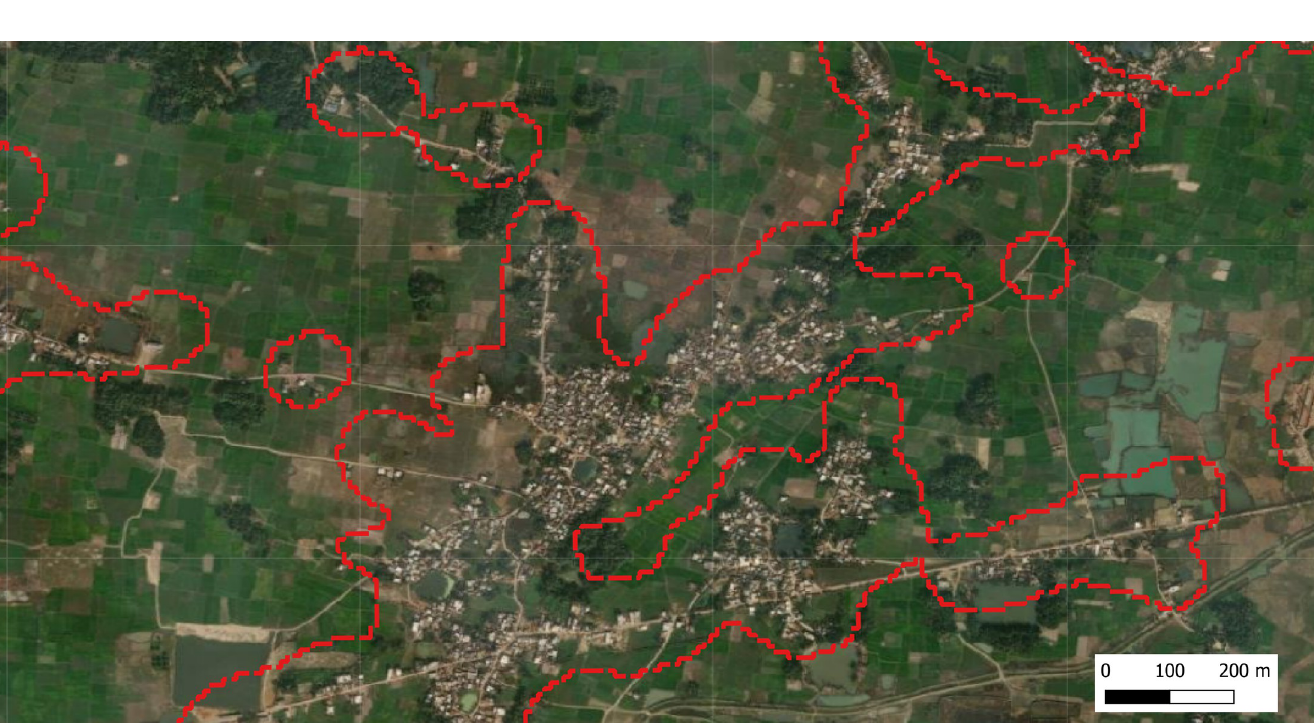
The participation rate was better in Bisfi, reasons for not being enrolled in the study were: temporary migration, Covid-19 pandemic.